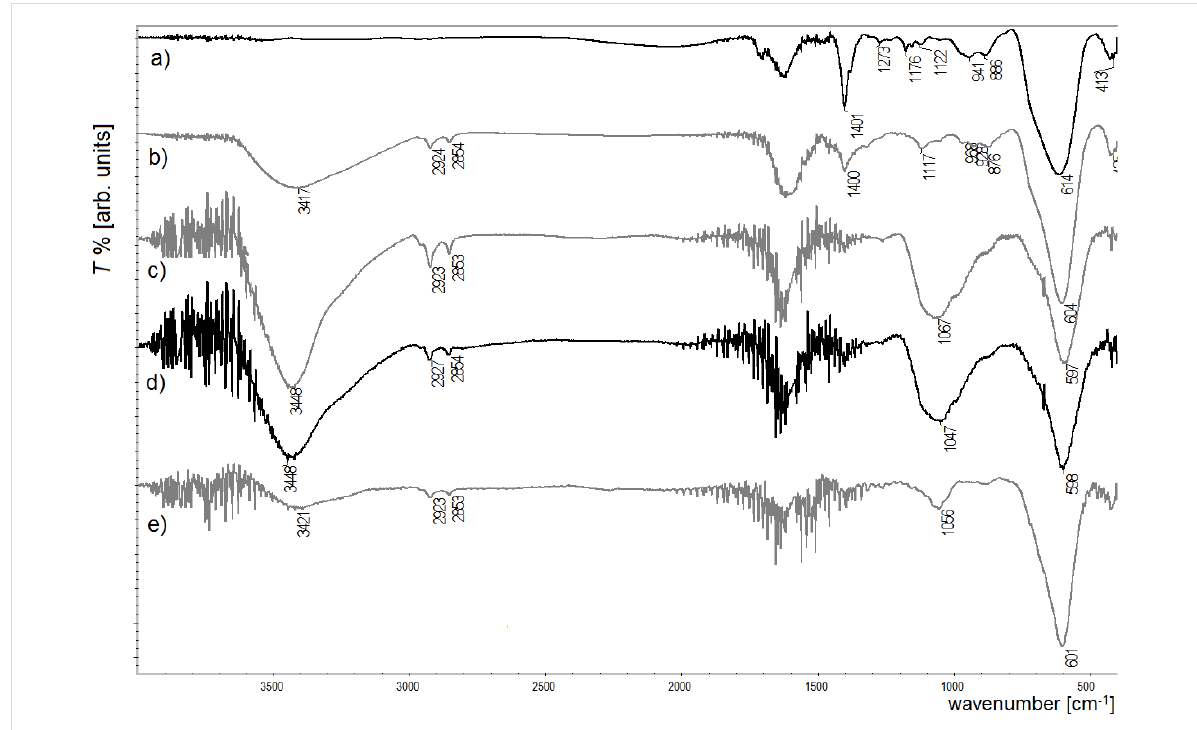
Figure 6: IR spectra of biocomposites with Ni 0.5 F 2.5 O 4 nanoparticles in the core and with different enzymes on the surface: a) reference sample with- out modification, b) albumin, c) glucose oxidase, d) lipase, e) trypsin.